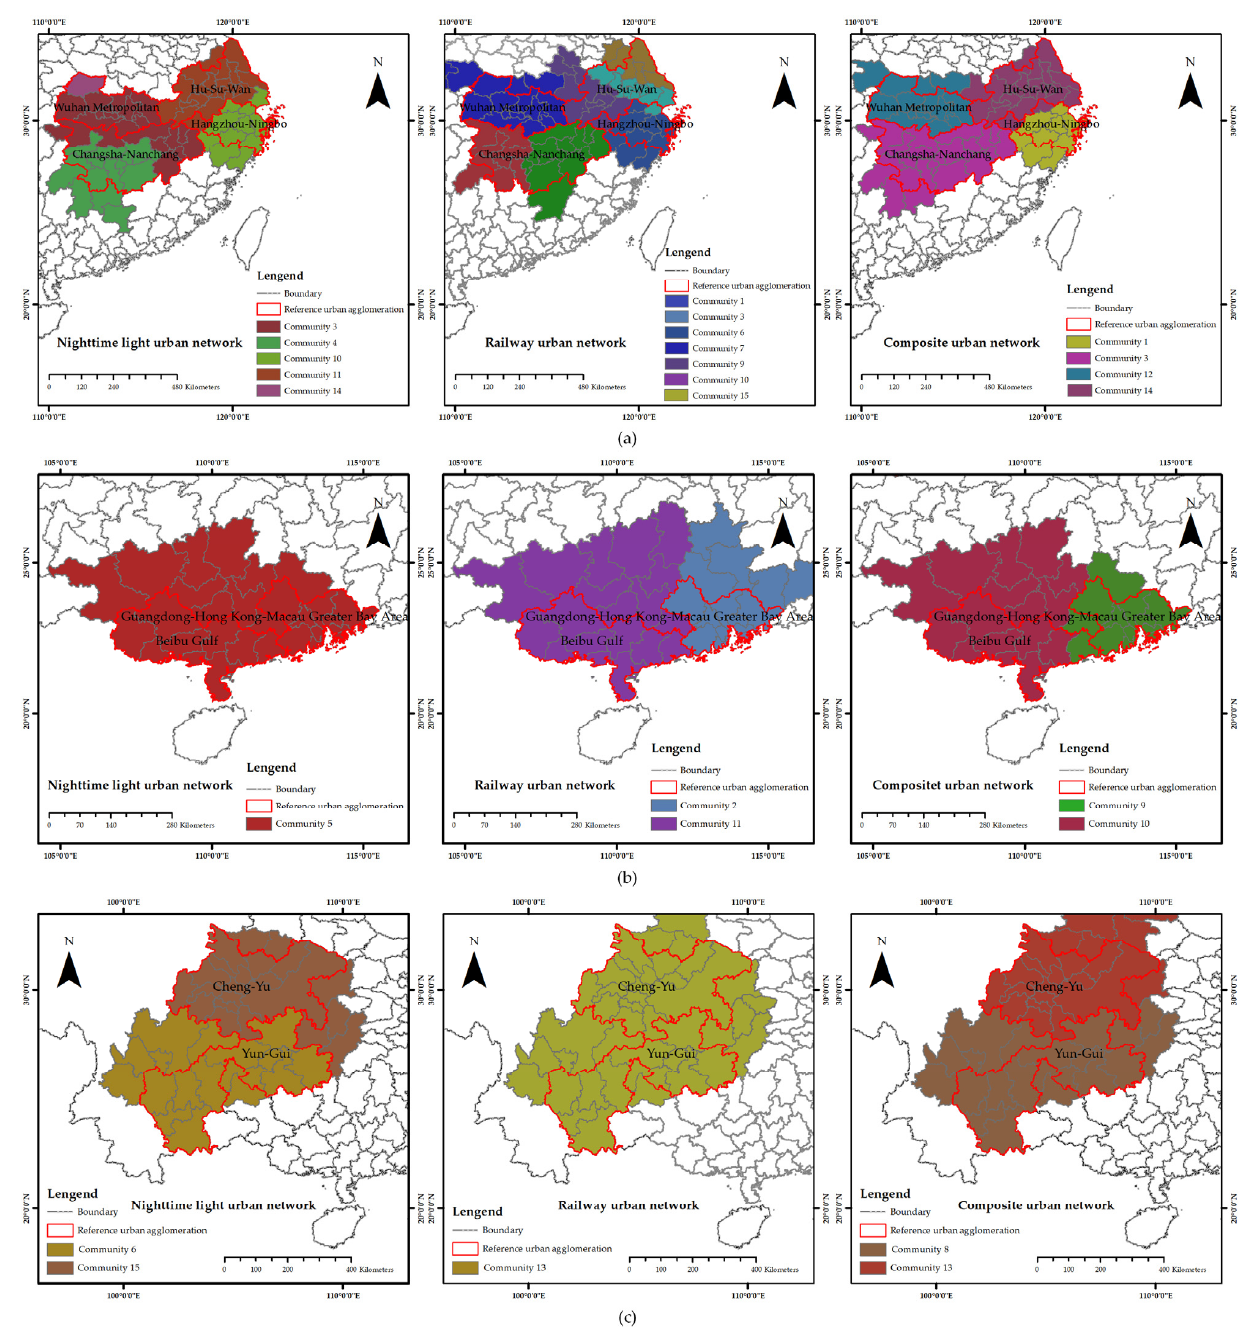
Figure 12. Details of the urban agglomeration identification results. ( a ) The urban agglomeration in the middle and lower reaches of the Yangtze River; ( b ) The urban agglomeration in the southern region; ( c ) The urban agglomeration in the southwest region.